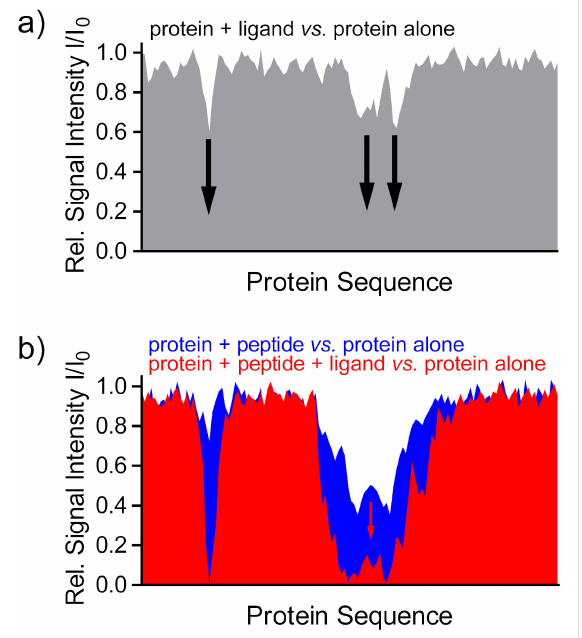
Figure 4: Relative signal intensities can be used to identify ligand binding sites (schematic representation of a hypothetical titration). (a) Binding of the ligand results in a reduction of the relative signal intensi- ties I / I 0 (protein with ligand vs. protein alone) of residues in proximity of the binding site due to line broadening. (b) The stabilizing effect of a ligand on a protein–peptide interaction in a ternary complex results in an additional decrease of relative signal intensities for the protein residues affected (red), compared to the binary complex of protein and peptide in the absence of a ligand